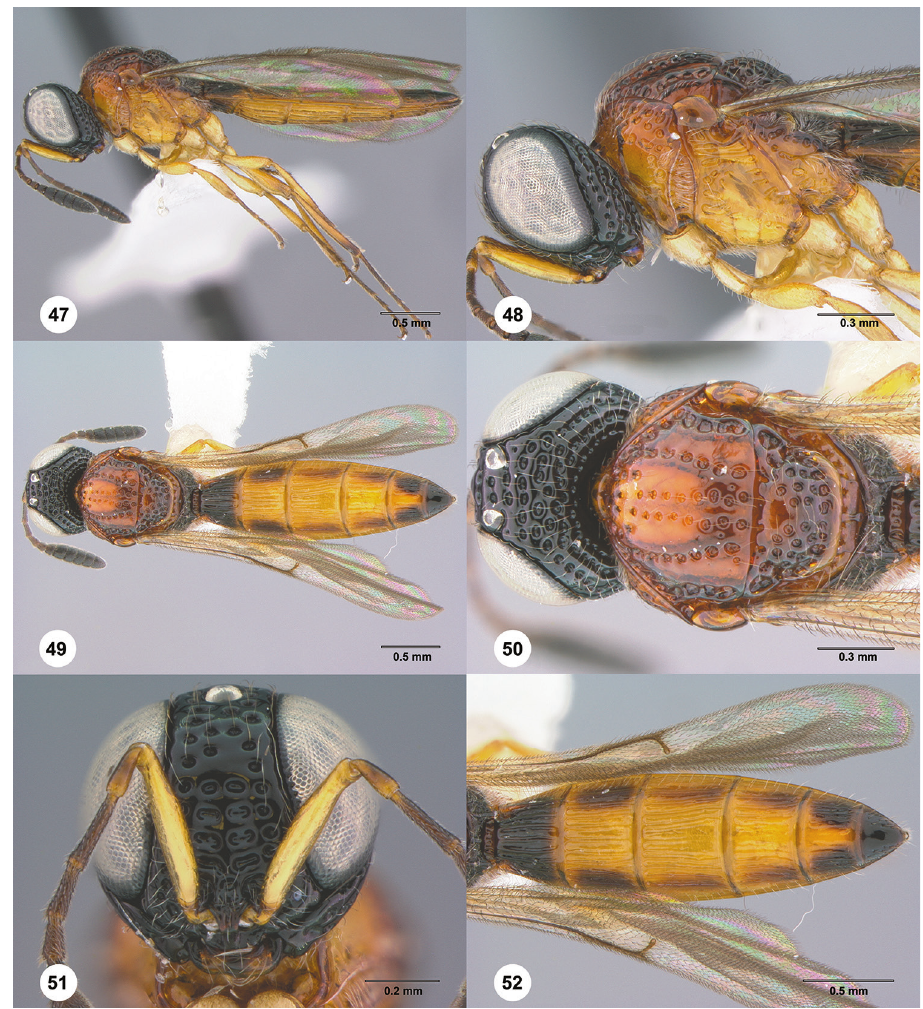
Figures 47–52. Habroteleia mutabilis sp. n., female, paratype (FBA 070892). 47 Lateral habitus 48 Head and mesosoma, lateral view 49 Dorsal habitus 50 Head and mesosoma, dorsal view 51 Head, anterior view 52 Metasoma and wings, dorsal